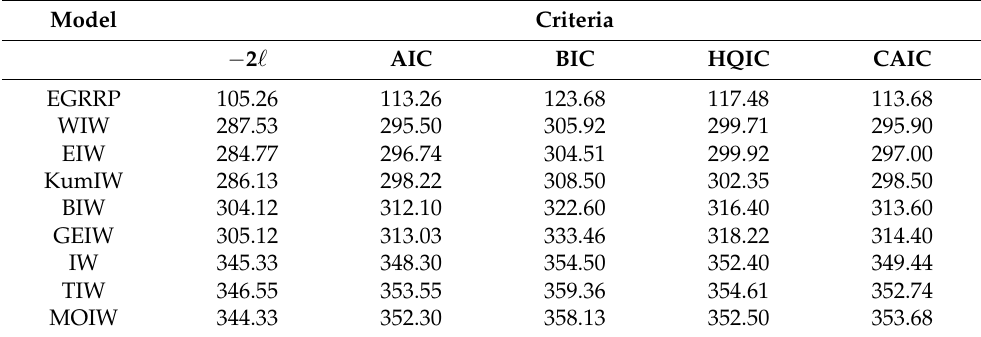
Table 9. − 2 (cid:96) , AIC, BIC, HQIC, and CAIC for the 1 st dataset.